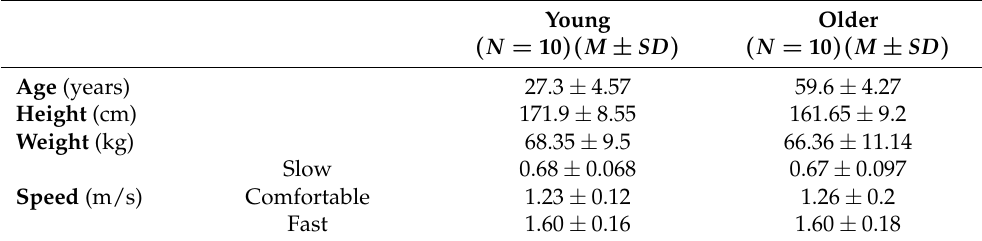
Table 1. Main characteristics of the study